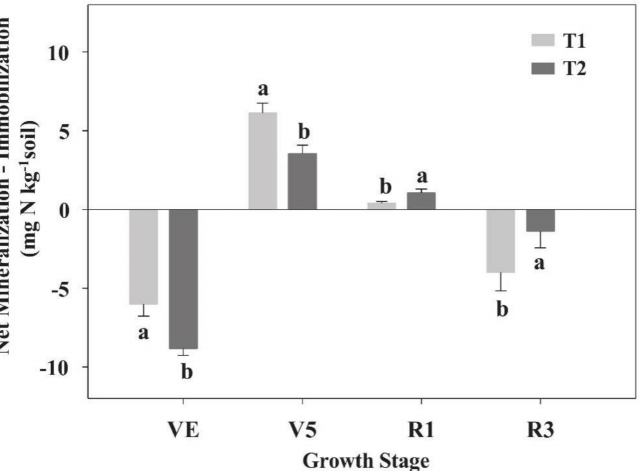
Figure 4. Net nitrogen mineralization − immobilization (negative values indicate net immobilization while positive values indicate net mineralization) under T1 (surface residue) and T2 (incorporated residue) treatments at four maize growth stages in the pot experiment. Mean value ± standard error ( n = 4) is shown. Different lower-case letters at the same growth stage indicate statistically significant differences at p <